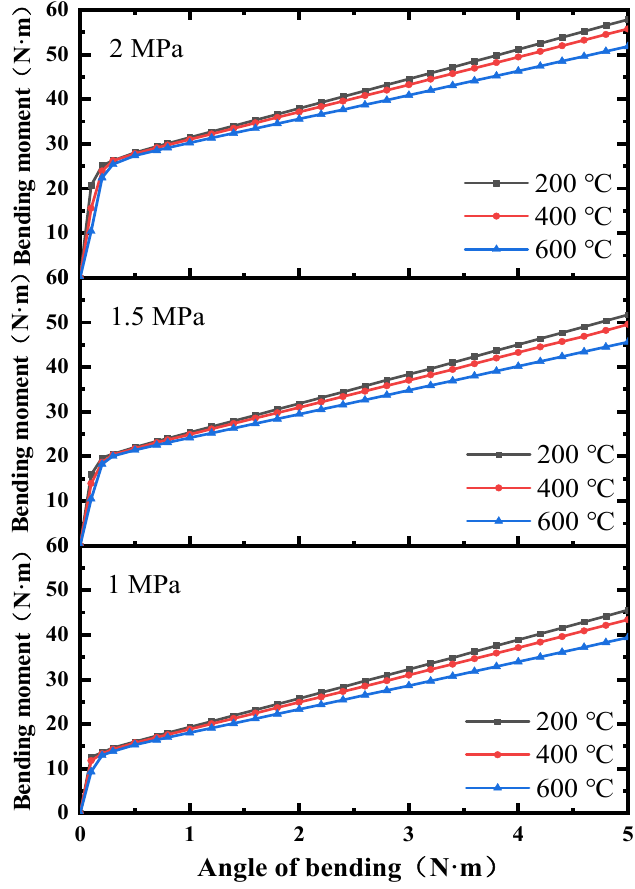
Figure 11. Bending characteristics of the ball joint without the ends blocked.